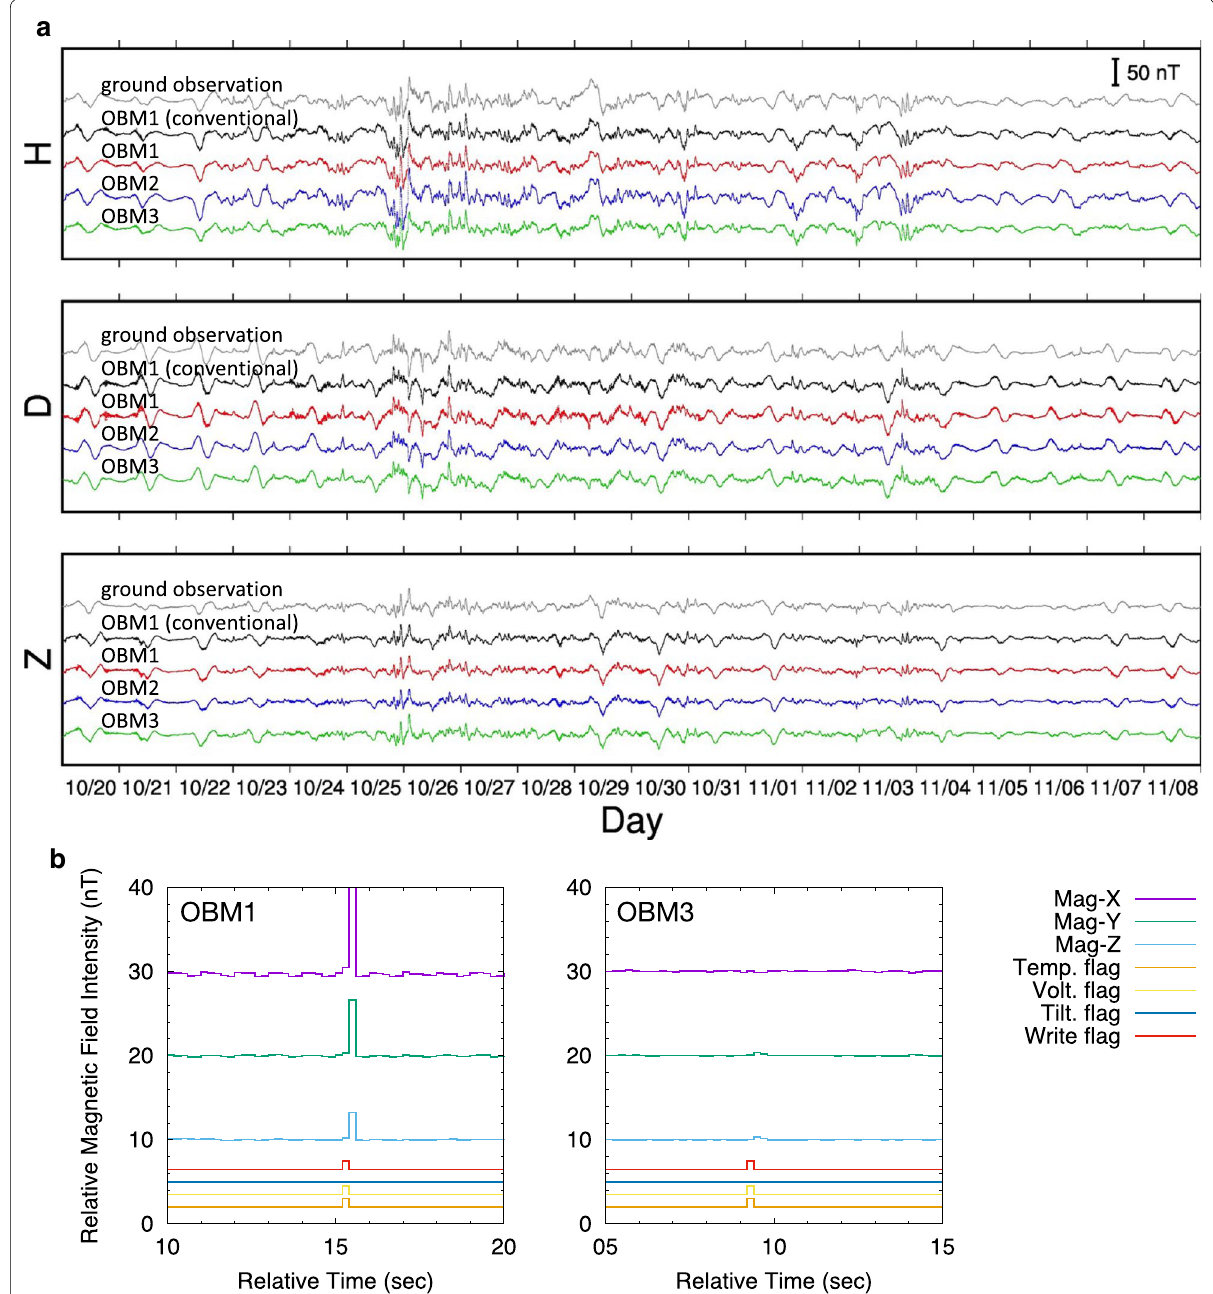
Fig. 3 a Examples of geomagnetic field variation data of every 60 s from October 20 to November 8, 2016. The north component (H), the east component (D), and the vertical downward component (Z) of the geomagnetic field variation in the geomagnetic coordinate system are shown from the top panel to the bottom. Observation data by the conventional magnetometer at site OBM1 and from the ground-based observatory Kakioka, Japan, are also plotted for comparison. Note that these plots do not include data points at the time that the control boards simultaneously measured tilt, temperature, and primary battery voltage. b Raw data examples of three-axis magnetic fields at sites OBM1 and OBM3 in October 22, 2016, with flags for temperature, battery voltage, and tilt measurements, and writing data on the